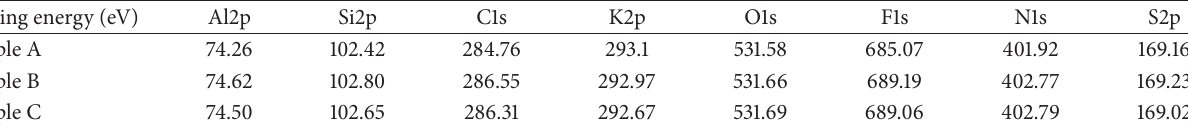
Table 2: XPS 𝐸 𝐵 data of sample systems adsorbing FW-134.